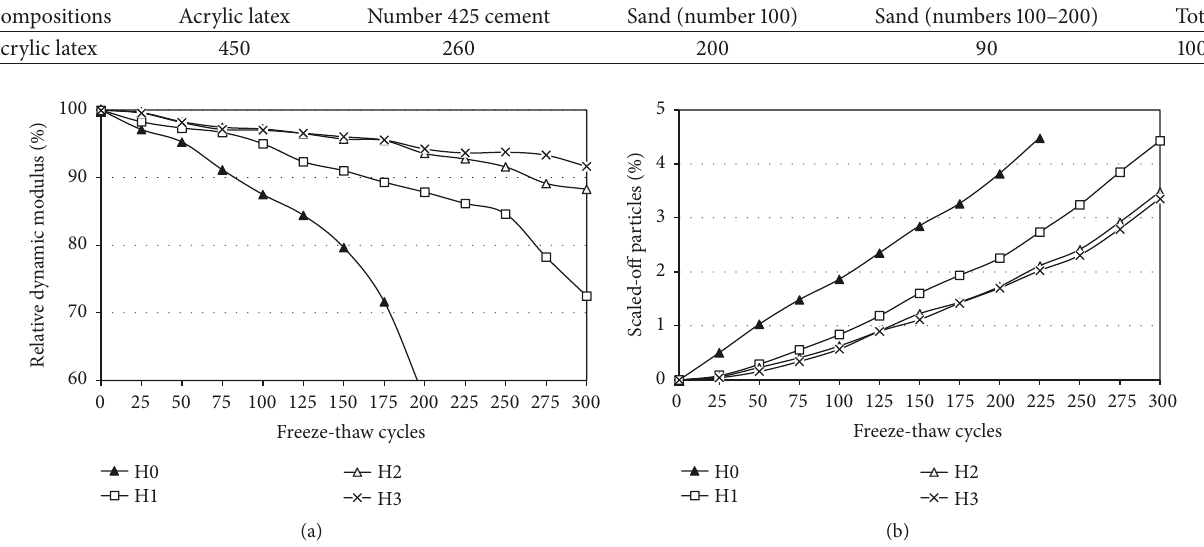
Table 3: Composition of the polymer-modified mortar.